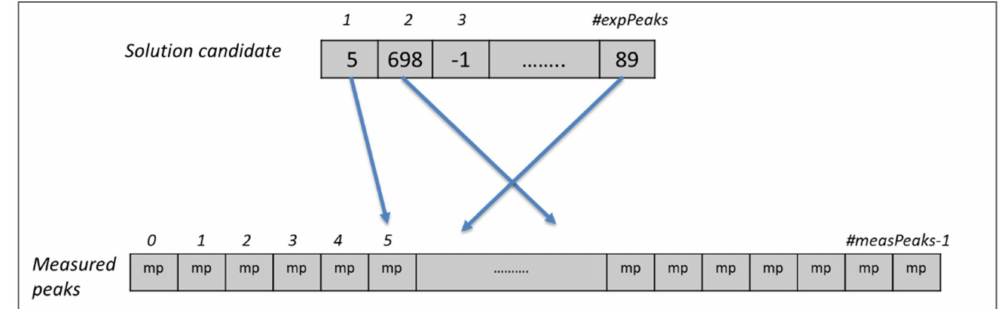
Figure 2. Solution candidate and measured peaks for one spectrum. The solution candidate represents a chromosome of our problem model, where each gene shows the expected peak that is assigned to that single measured peak. A value of − 1 (e.g., for expected peak 3) indicates that the expected peak is not assigned to any measured peak.